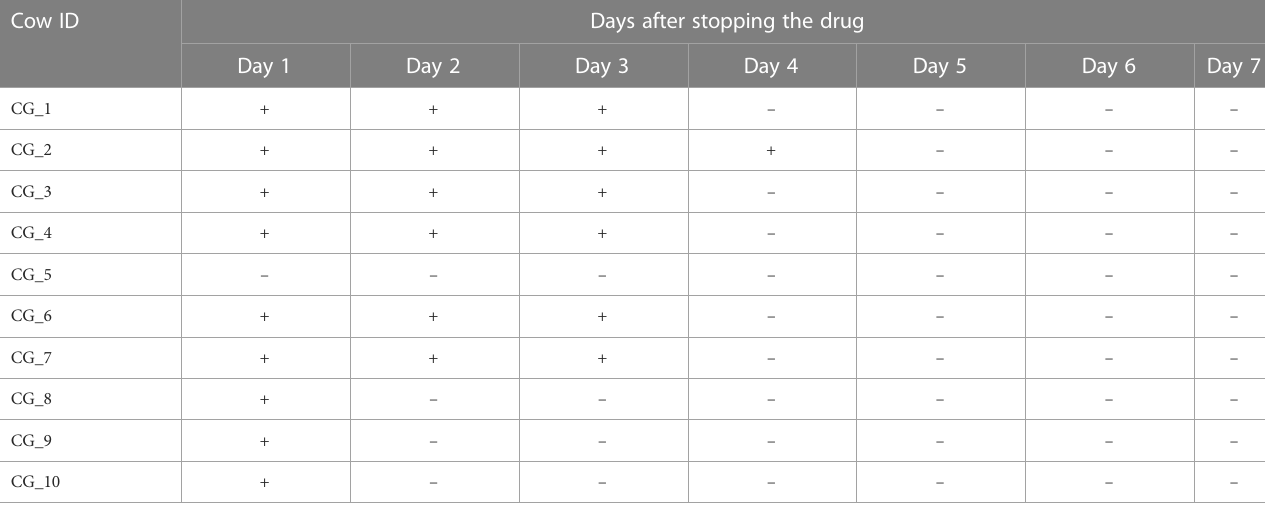
TABLE 2 Residue of geraniol in milk of dairy cows after stopping to inject geraniol. Cow